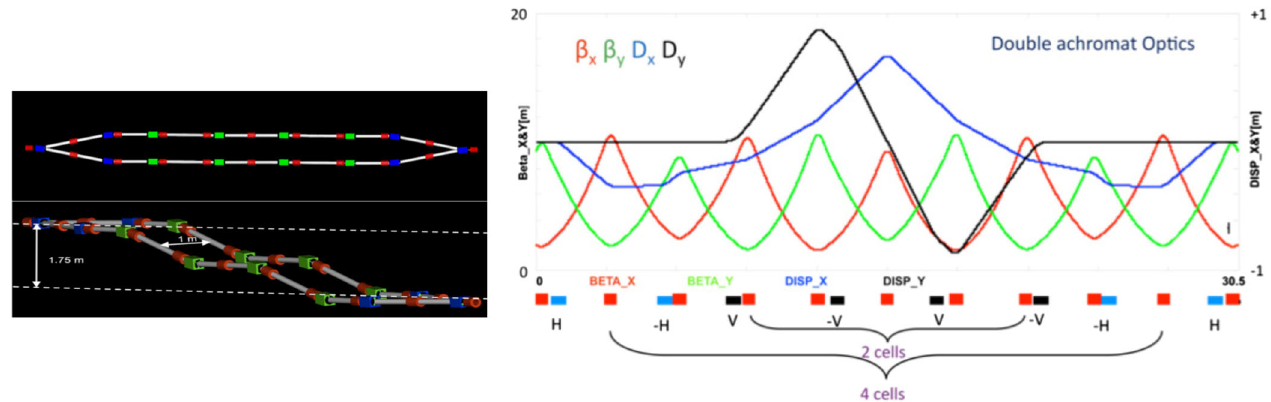
FIG. 10. Left: Layout of the injection chicane from the muon linac into the first RLA in two projections. Right: lattice details of the injection chicane in